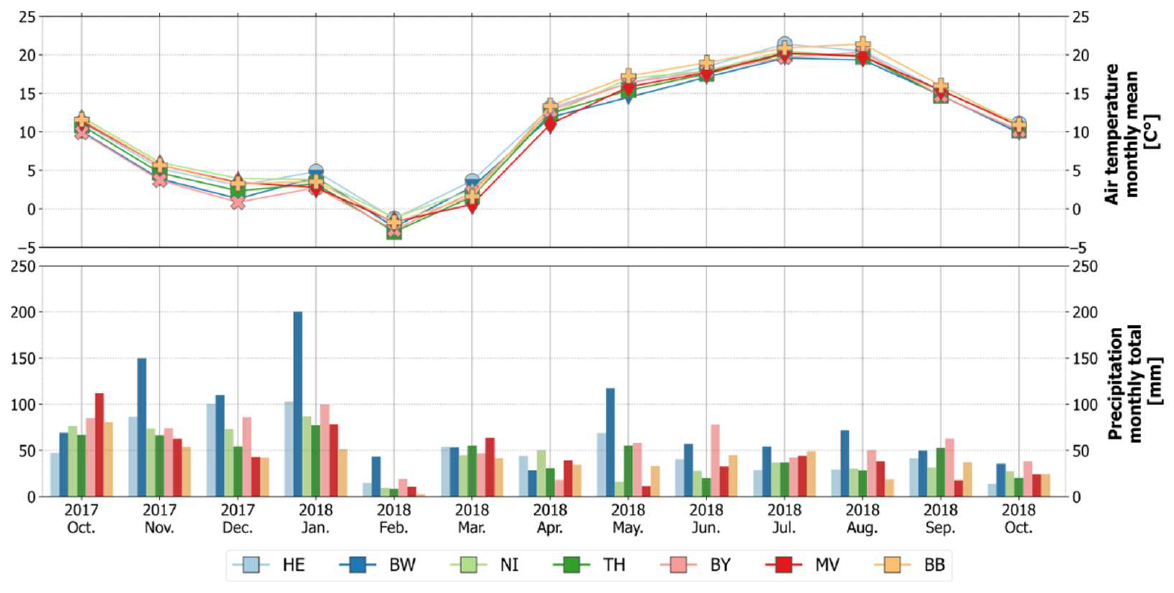
Figure 2. Mean monthly air temperature ( top ), monthly total precipitation ( bottom ) across the seven study sites from October 2017 to October 2018. Data source: German Weather Service (DWD).